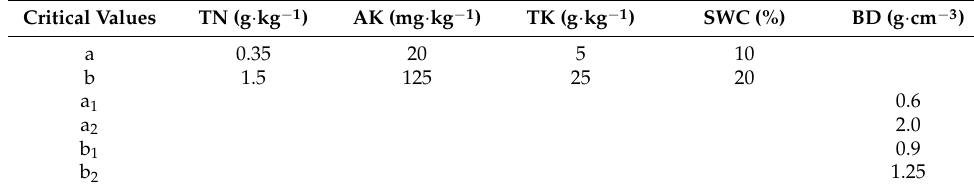
Table 3. The critical values in Formulas (2) and